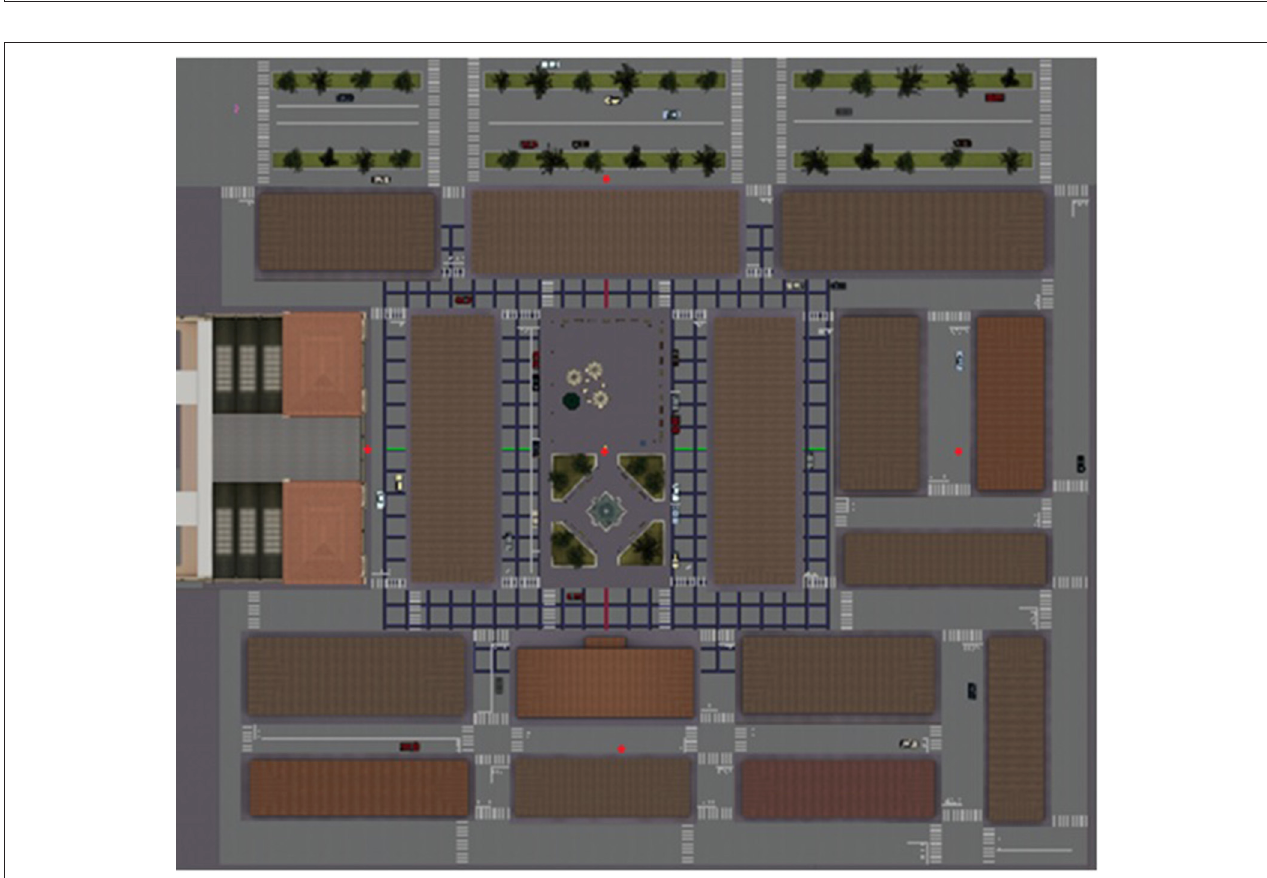
FIGURE 2 | The map of the virtual city. The city was built around a central square with a fountain and a bar with some tables, which represents the starting point of the navigation. There were buildings and shops spread out in the city. In the northern part of the city, there was a large street surrounded by trees with some cars, whereas the southern part was more